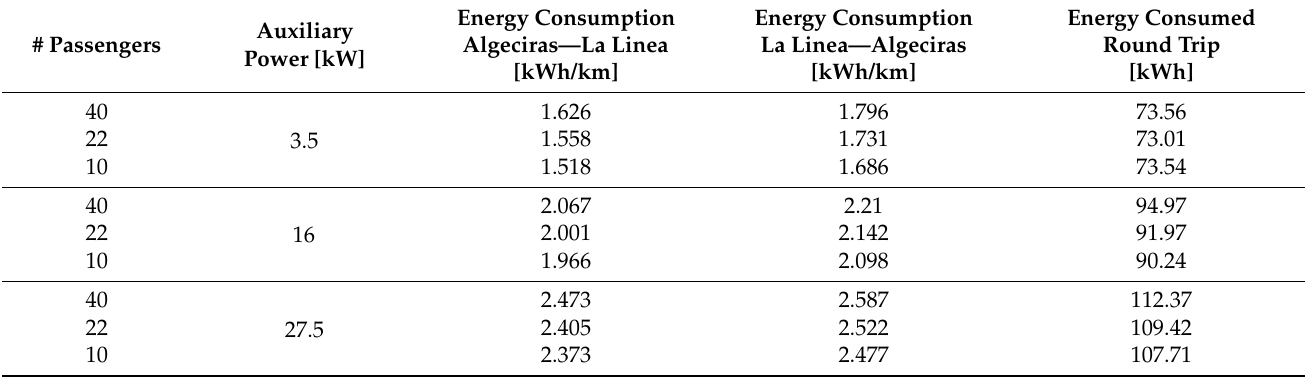
Table 4. Line M-120 simulation results for electric